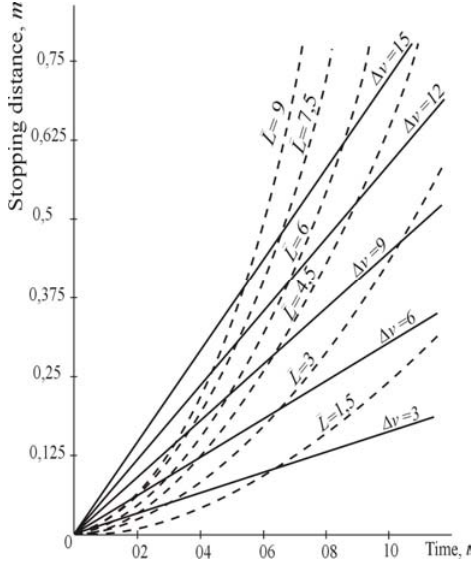
Fig 3. Stopping distance and time interdependence of speed change and deceleration level